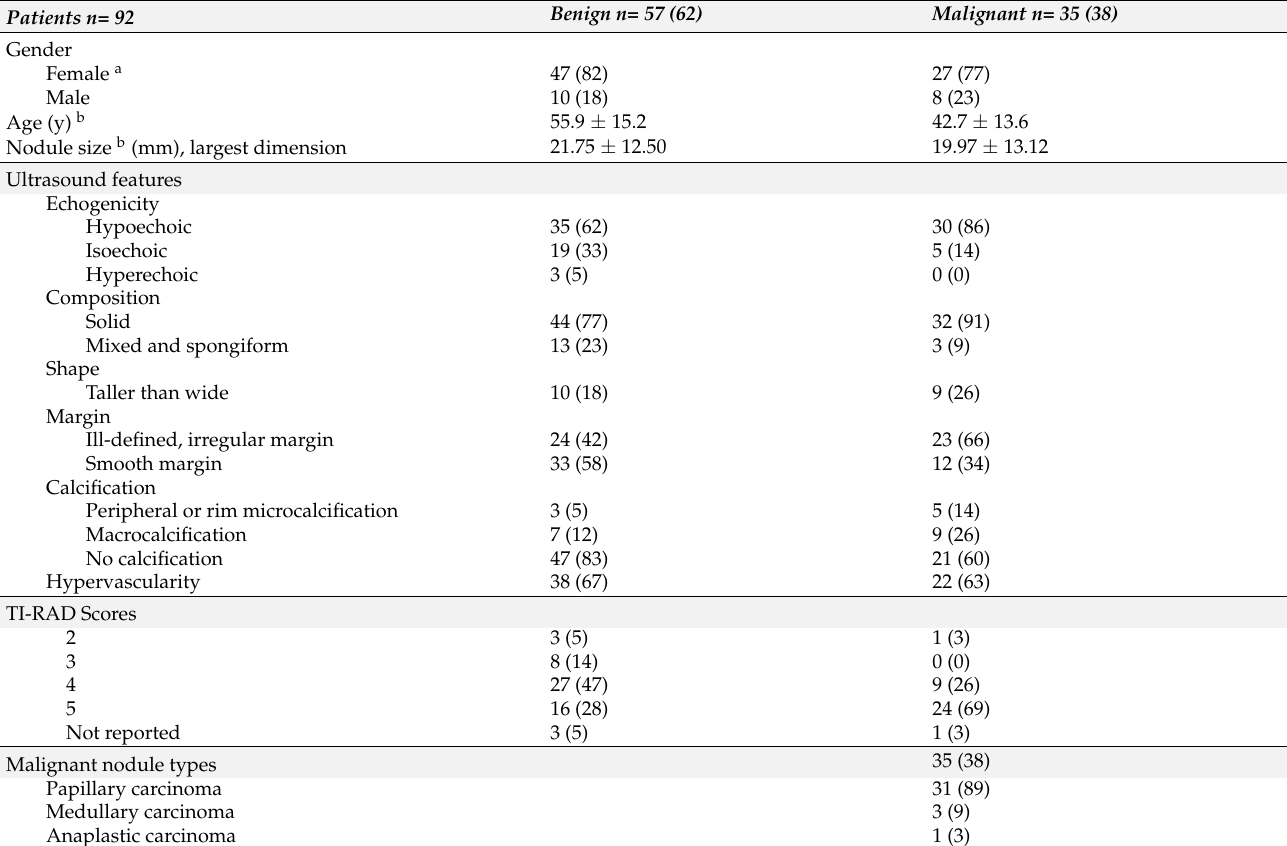
Table 1. Participant demographic characteristics and malignant nodule